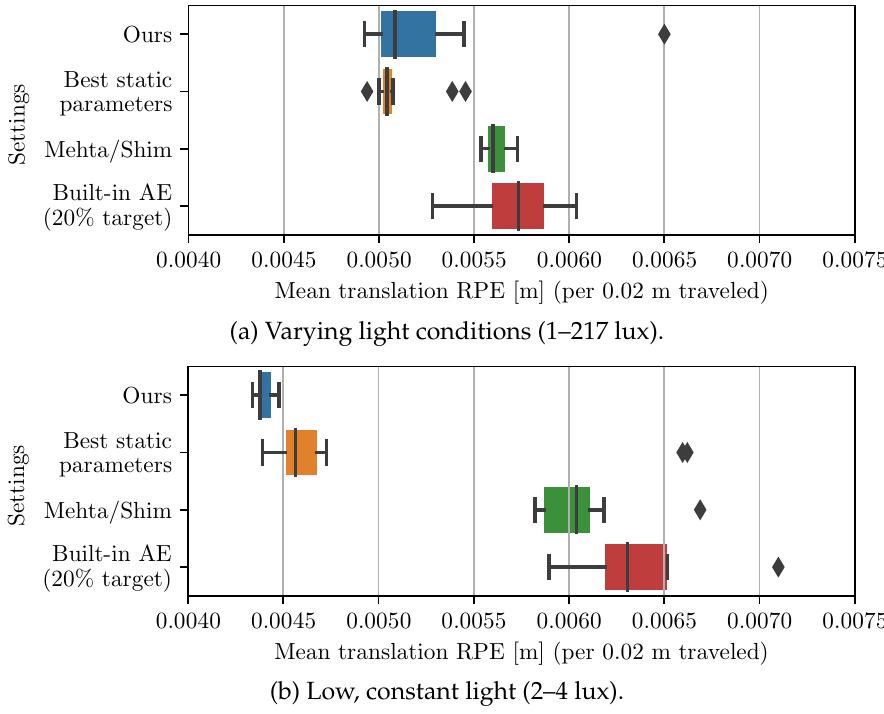
Figure 13. VO performance of different AE algorithms with the same repeated trajectory where each box represents the distribution of results for a sequence post-processed 10 times with ORB-SLAM: ( a ) Sequences where lighting varies greatly (1–217 lux). ( b ) Sequences with low, but constant lighting (2–4